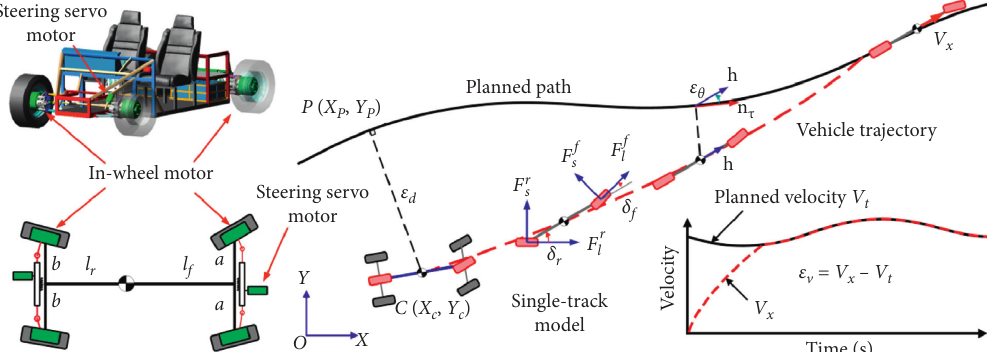
Figure 1: Schematic of a 4WS4WD vehicle